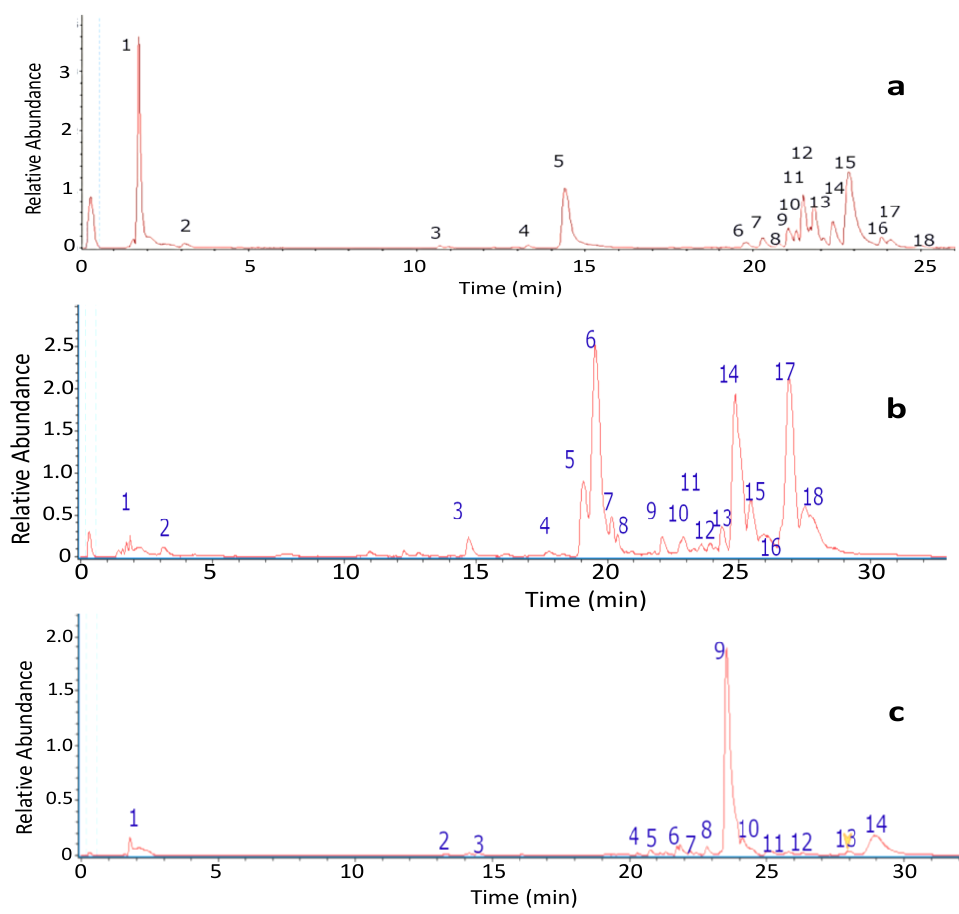
Figure 2. UHPLC-MS Chromatograms ( a ) Lecania brialmontii ; ( b ) Pseudephebe pubescens ; ( c ) Sphaerophorus globosus .